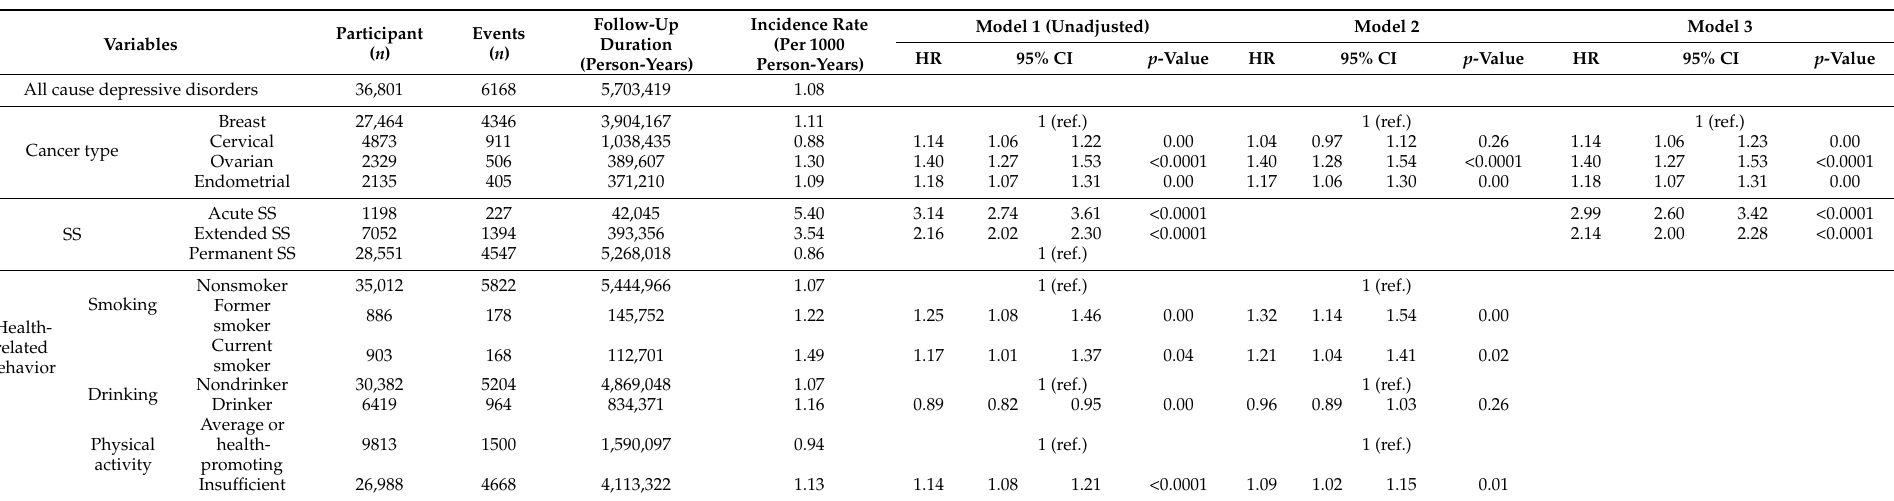
Table 3. Hazard ratios and 95% confidence intervals of depressive disorders based on cancer survivorship stage and health